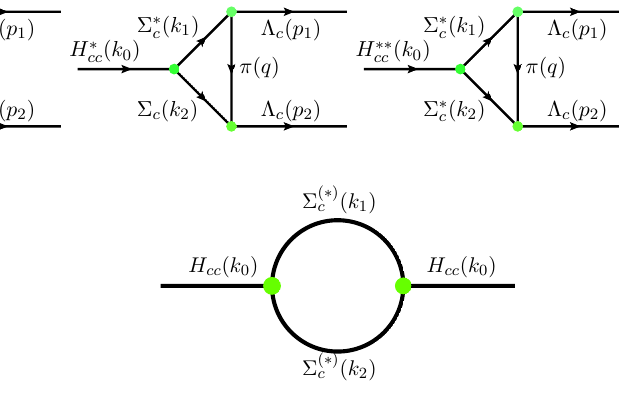
Fig. 2 Mass operators of the (cid:2) ( ∗ ) c (cid:2) ( ∗ ) c molecules